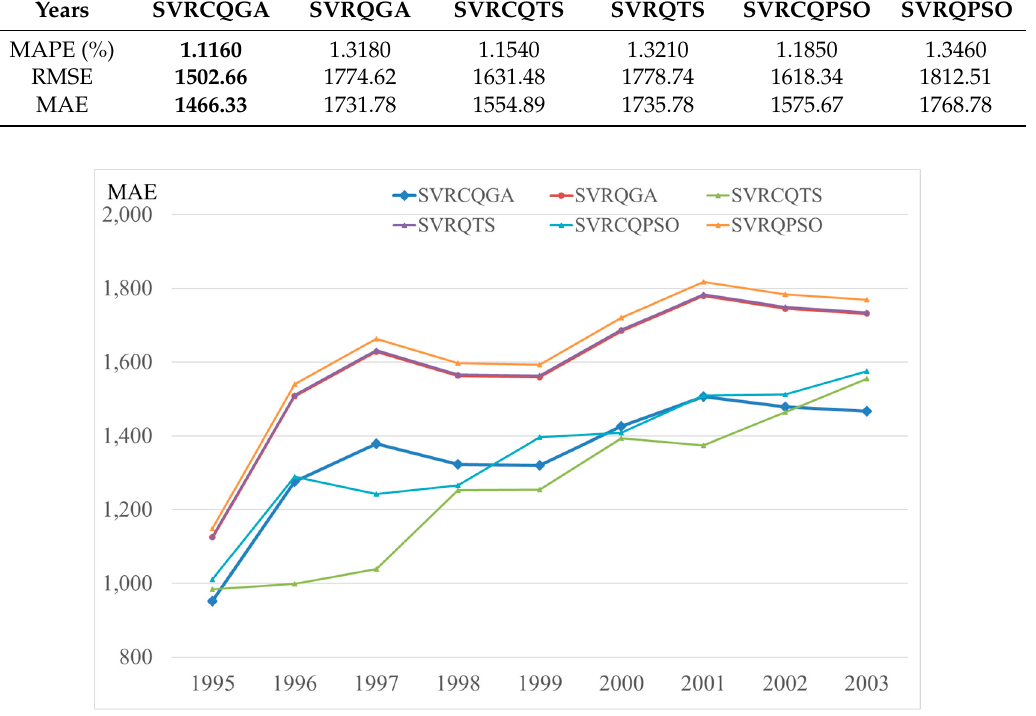
Figure 6. The cumulative differences of MAE for each competitive model (Example 2). Table 7. Wilcoxon signed-rank test and Friedman test (Example 2).